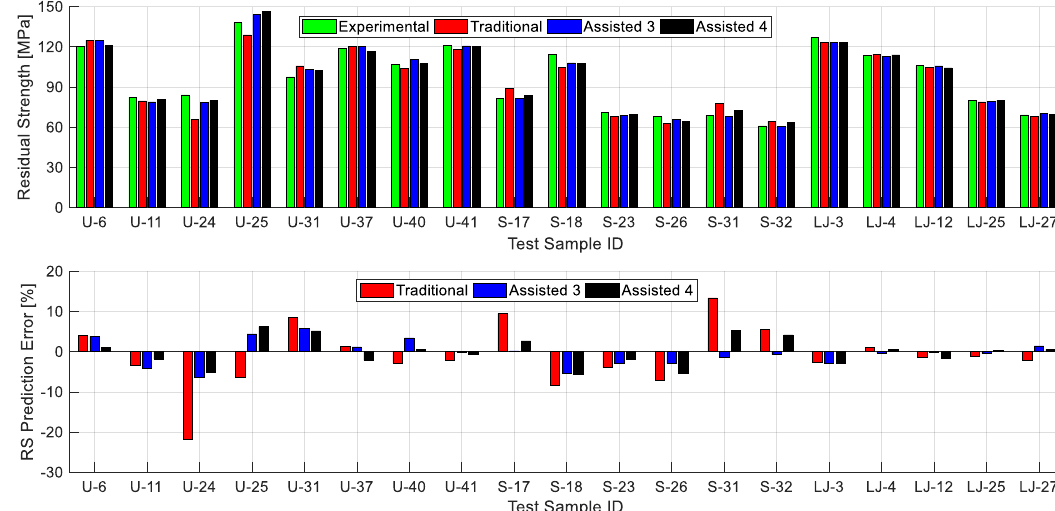
Figure 4. The experimental residual strength values along with the predictions obtained by the ANN model for the traditional and assisted approaches (assisted 3 and 4 only) for one of the testing datasets using the BR algorithm ( top ), together with the residual strength prediction errors ( bottom ). The shown ANN predictions are for the best one of the 80 random combinations of the testing datasets.